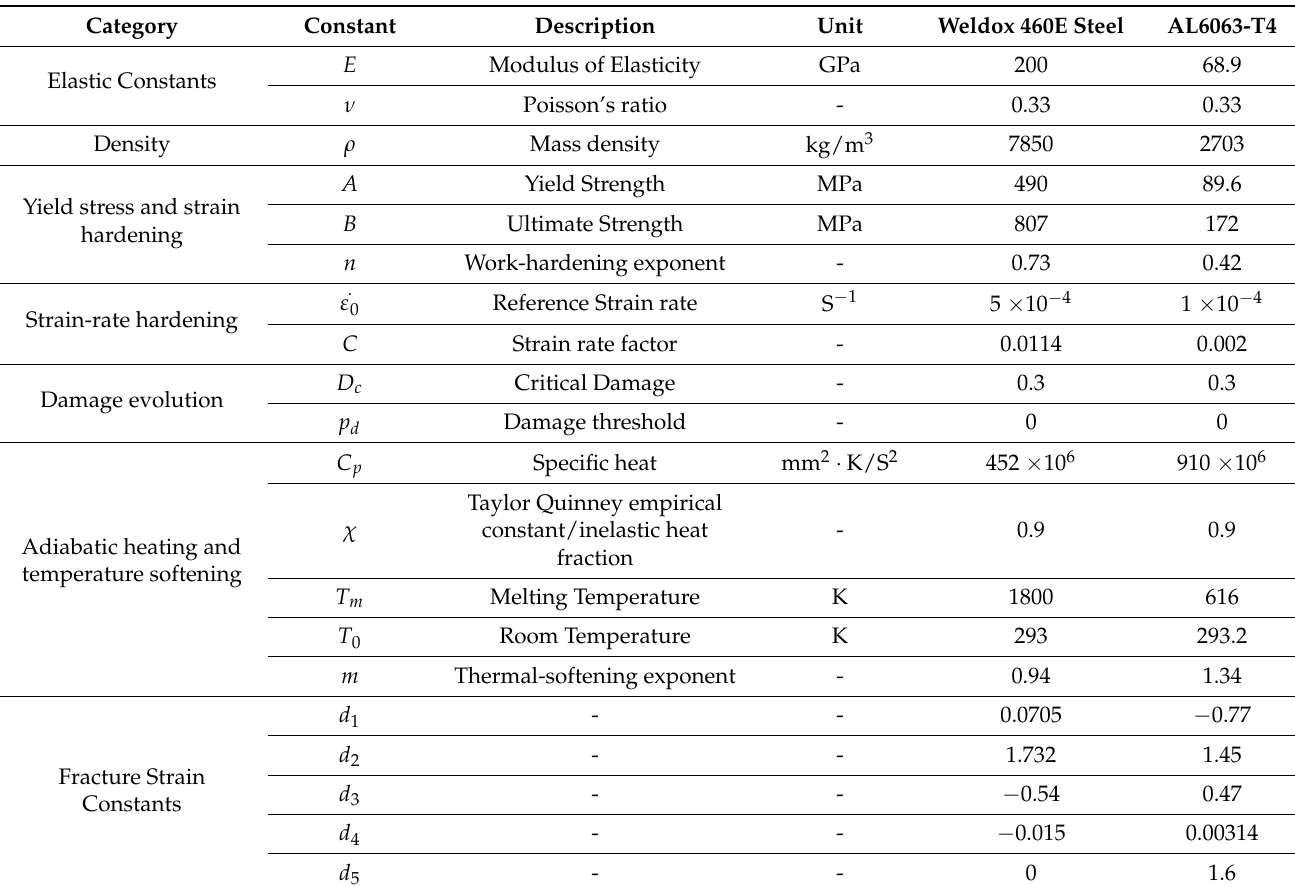
Table 3. Material parameters for Weldox 460E Steel [76] and AL6063-T4 aluminium [77] used for the frame and the corrugated core,